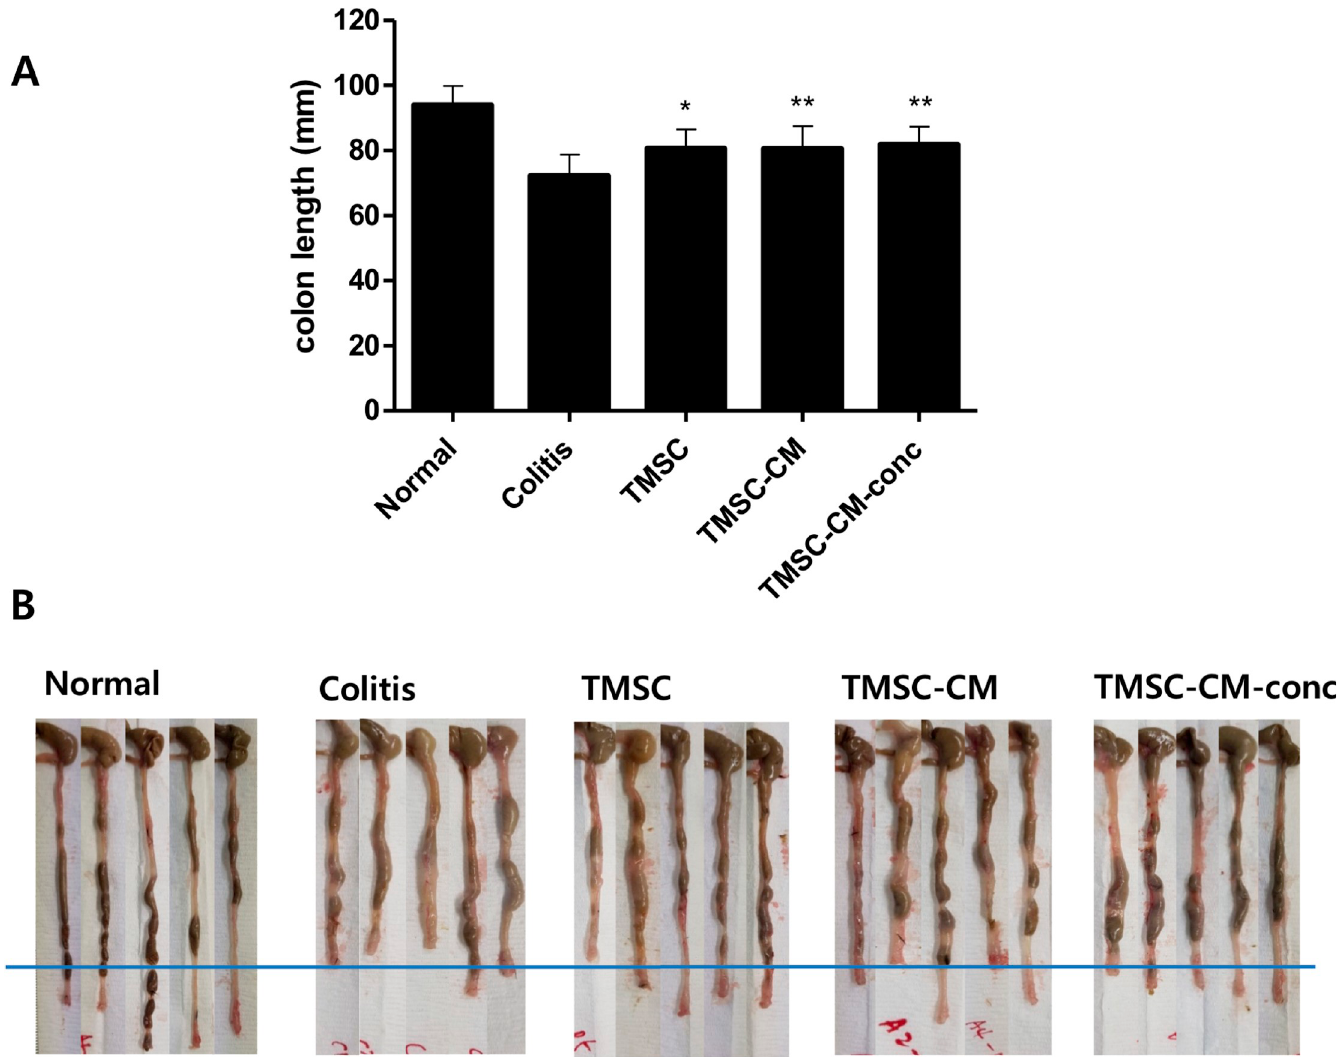
Fig 6. Colon length. (A) Colon length at the 30th day of experiment was significantly increased in TMSC, TMSC-CM, and TMSC-CM-conc group compared to the colitis control group. (mean with standard deviation, � p < 0.05, �� p < 0.01) (B) Resected colons of each group are